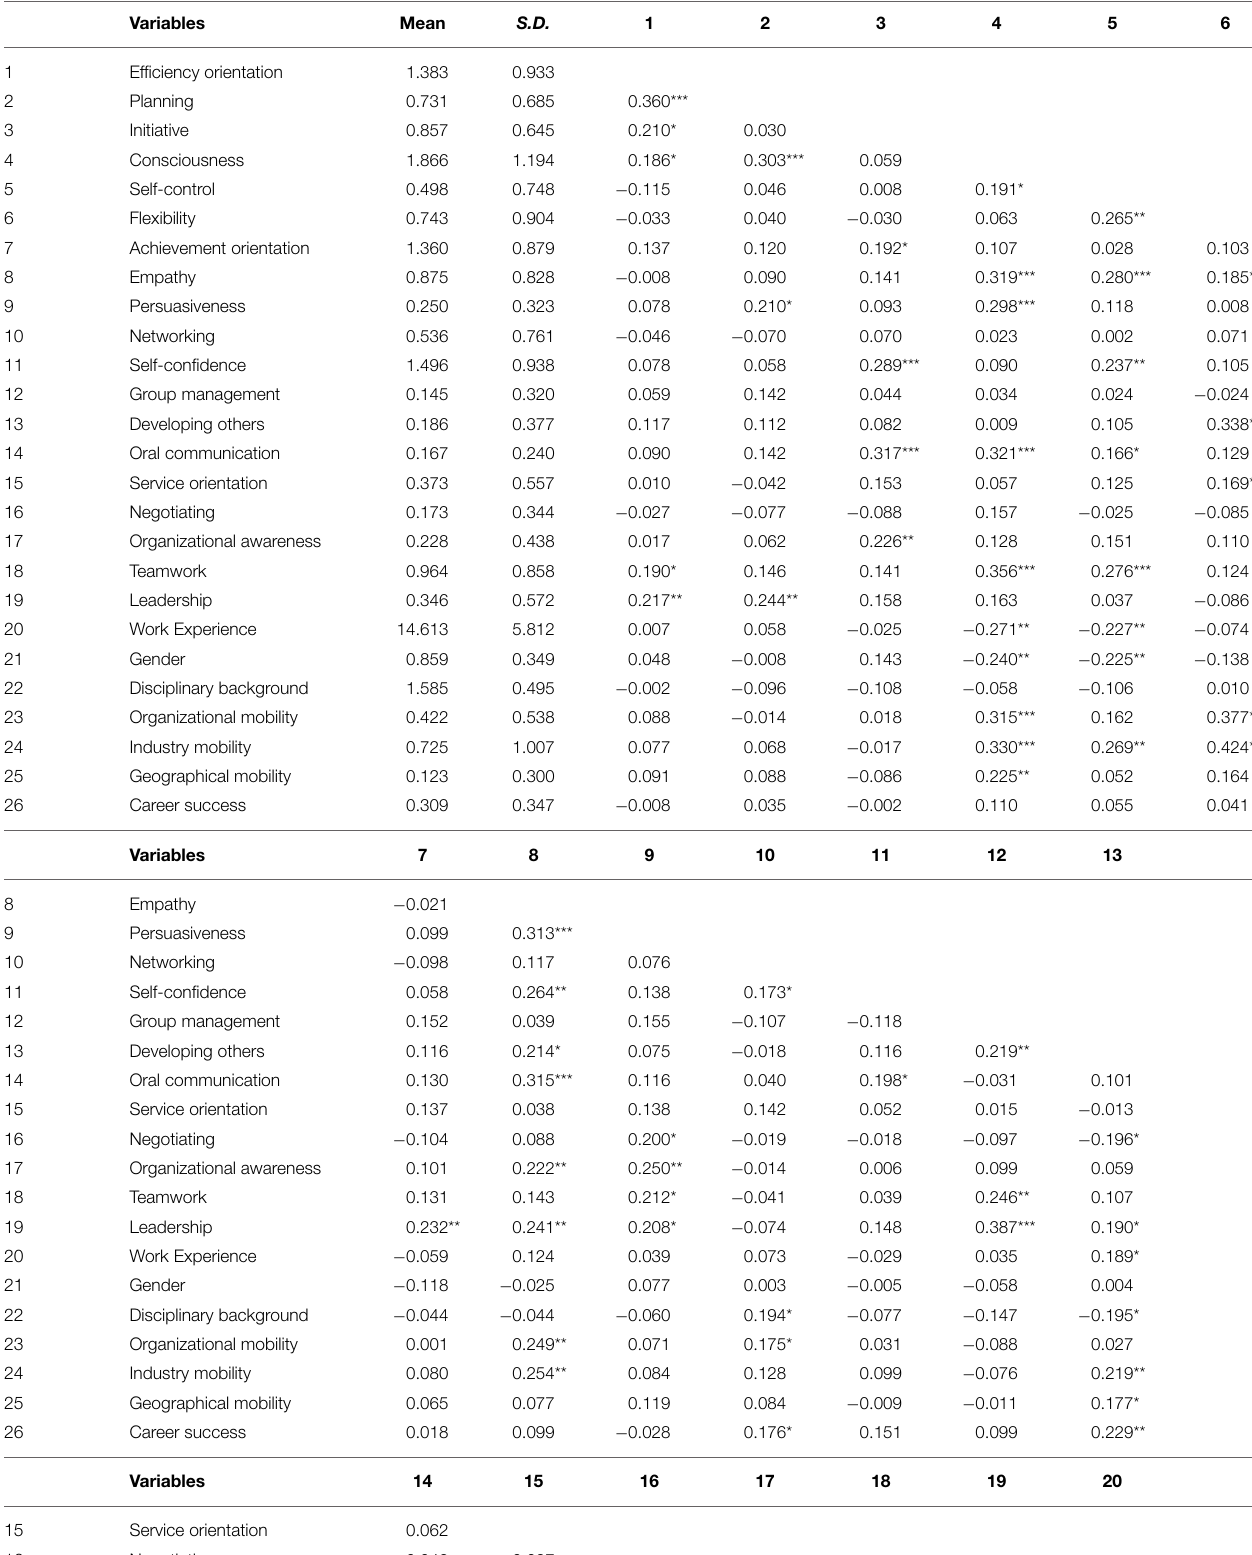
TABLE 2 | Means, standard deviations and